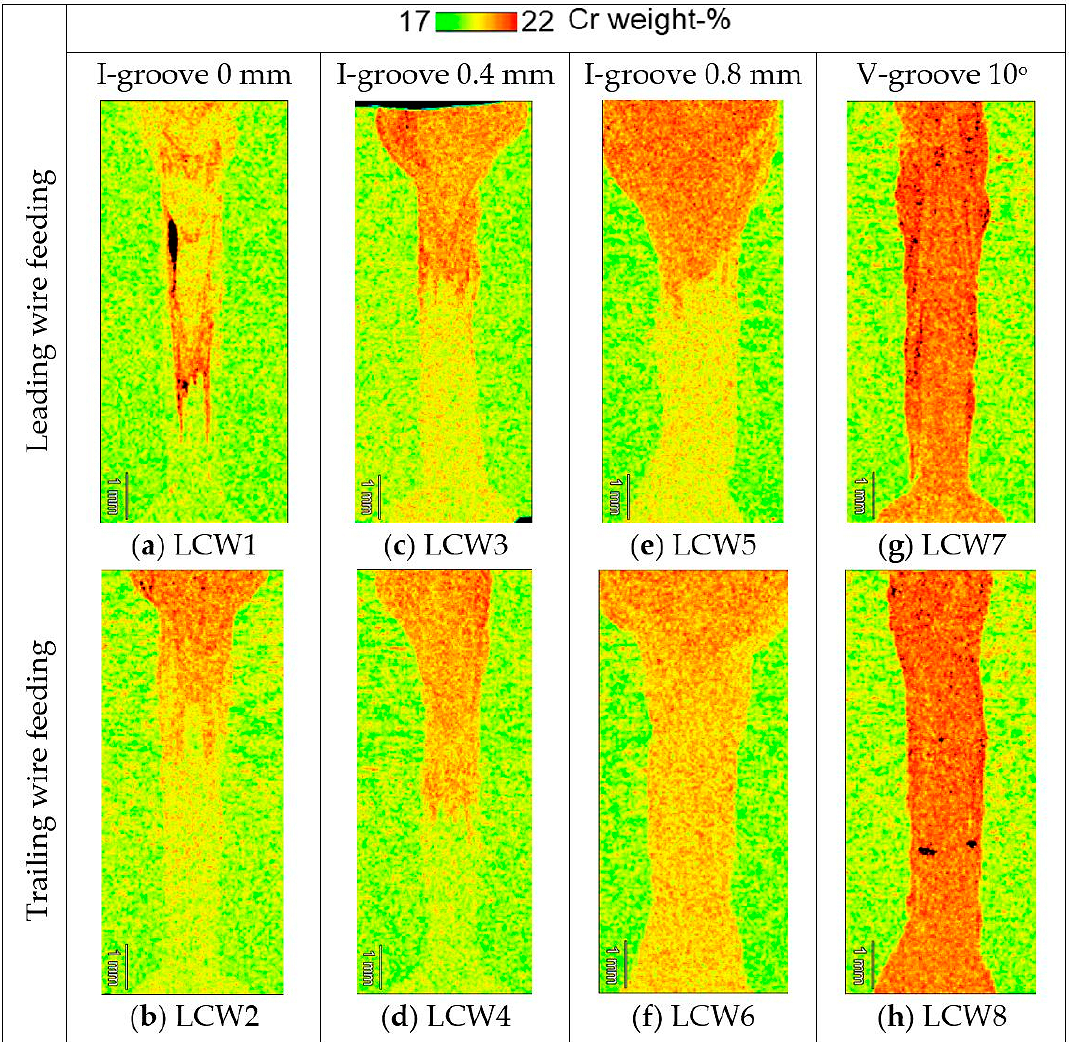
Figure 15. EDS mapping images ( a – h ) showing the distribution of chromium in laser cold-wire test welds.